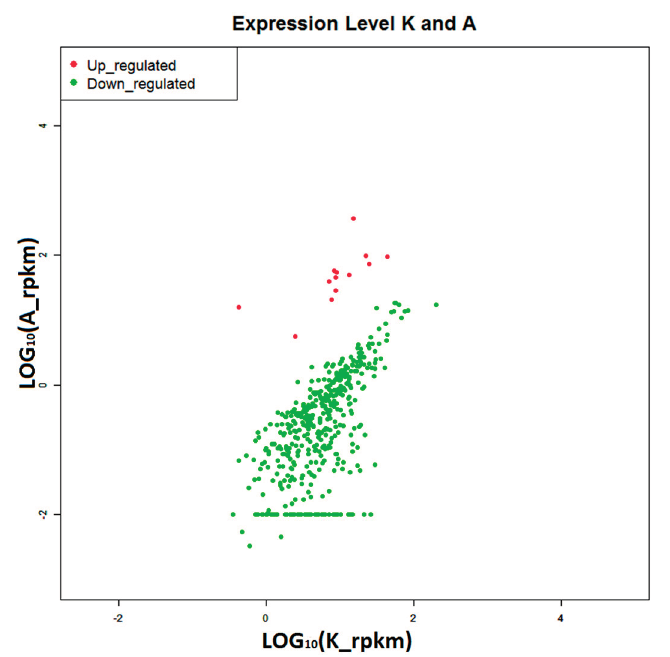
Figure 8. Differentially expressed genes from disease-resistant group (A), comparing with control group (K). Red points represent 13 up-regulated genes, and green points represent 345 down-regulated